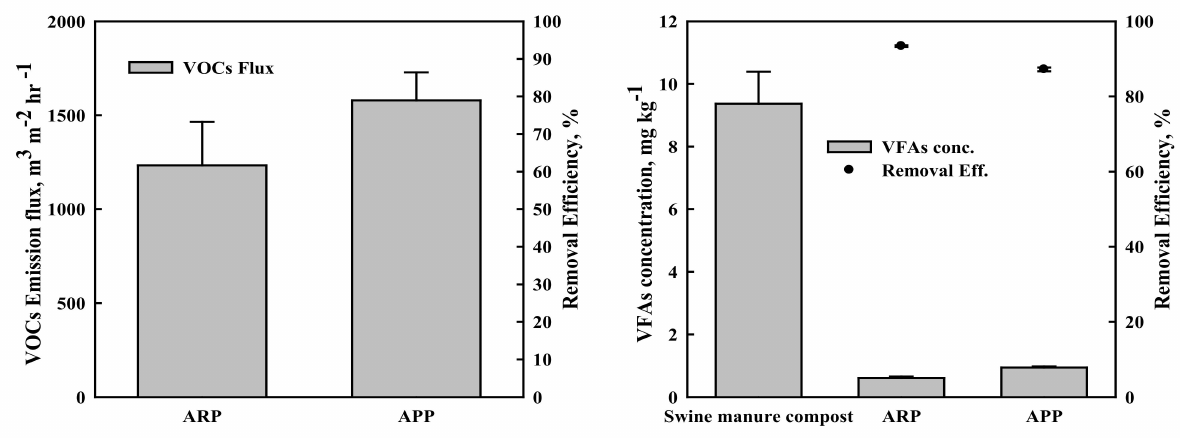
Figure 5. Volatile organic compound (VOC) flux and volatile fatty acids (VFAs) concentration from swine manure compost, ARP, and APP. Error bars indicate standard error. ARP: activated rice hull biochar-manure compost pellet. APP: activated palm biochar-manure compost